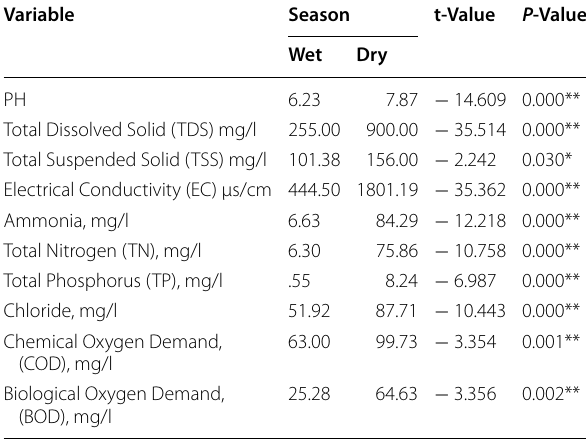
Table 2 Mean values of seasonal water quality indicators in the Kebena watershed Variable